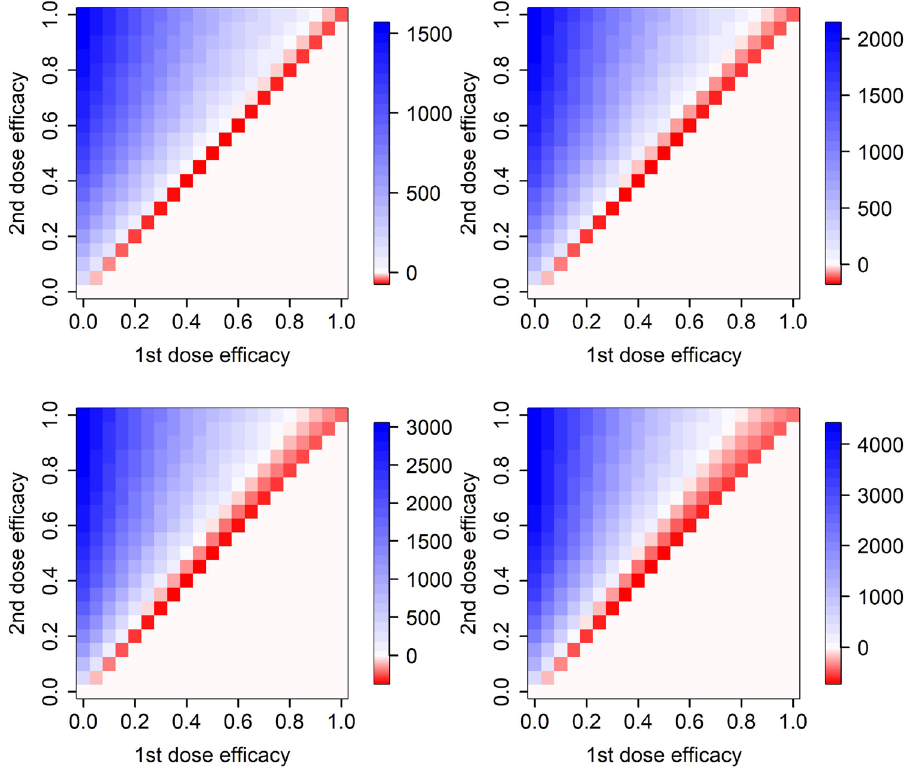
Figure 6. Efficacy of delaying the second vaccine dose by 3 weeks from 21 to 42 days, assuming vaccine effect on the probability that a vaccinated person gets infected by contact with an infectious one, and at the same time on the probability that a vaccinated person becomes symptomatic when infected. Top left: contacts at 35% of the pre-pandemic state, top right: contacts at 45% (real situation in Czechia), bottom left: contacts at 55%, bottom right: contacts at 65%. Only model H is used